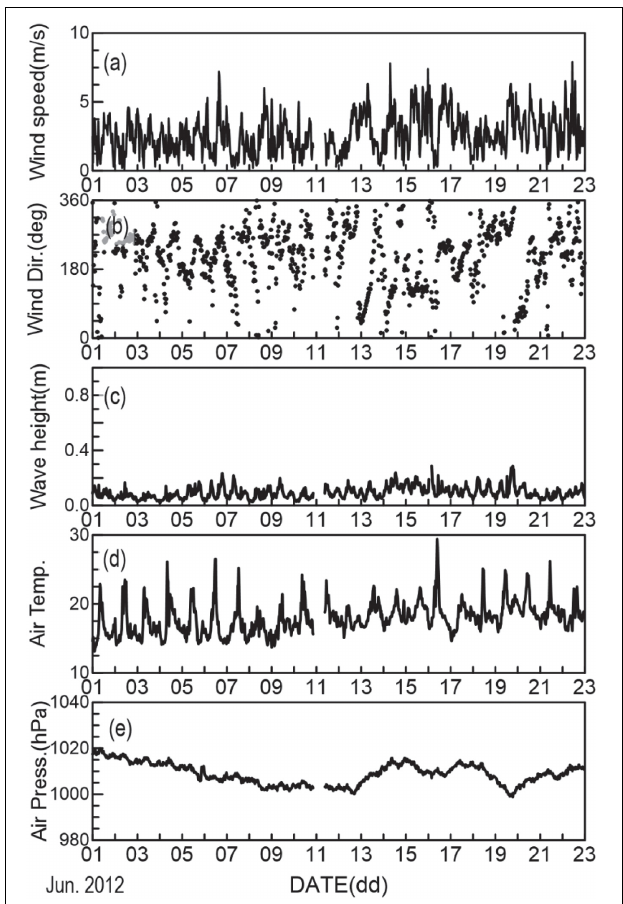
FIGURE 10 | Time variation of air properties measured by INBUS-2 at location P1 from June 1 to 23, 2012: (a) wind speed, (b) wind direction, (c) wave height, (d) air temperature, (e) air